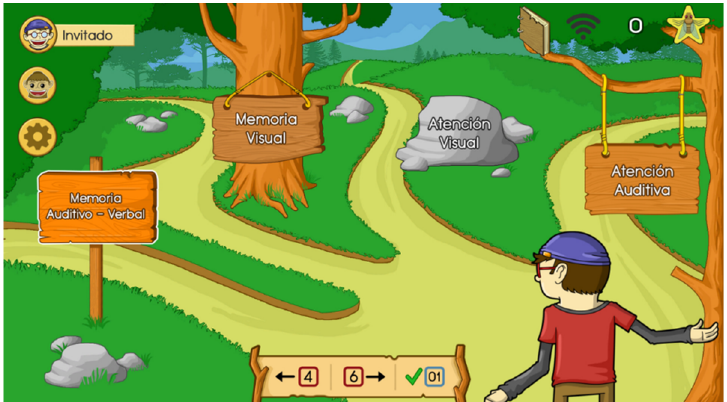
Figure 2. HapHop-Physio’s interface for selecting subdomains.